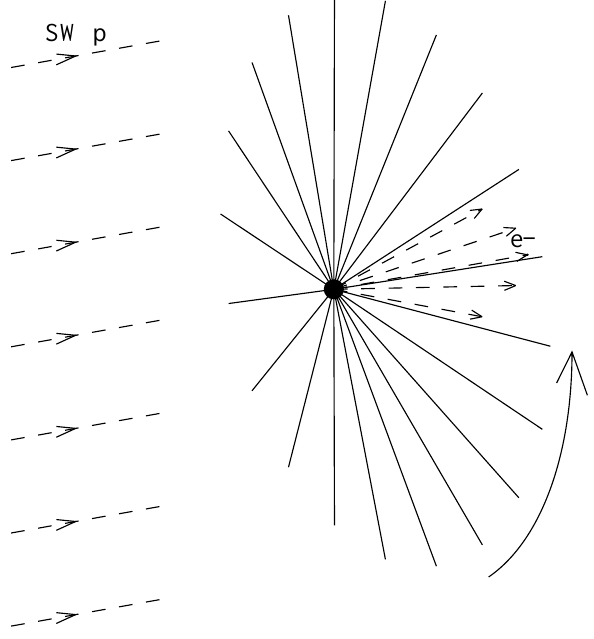
Fig. 1. Schematic description of the original spinning, positive polarity electric sail. Charged, centrifugally stretched tethers gather momentum from the solar wind. The charging is maintained by an electron gun mounted on the spacecraft (middle).